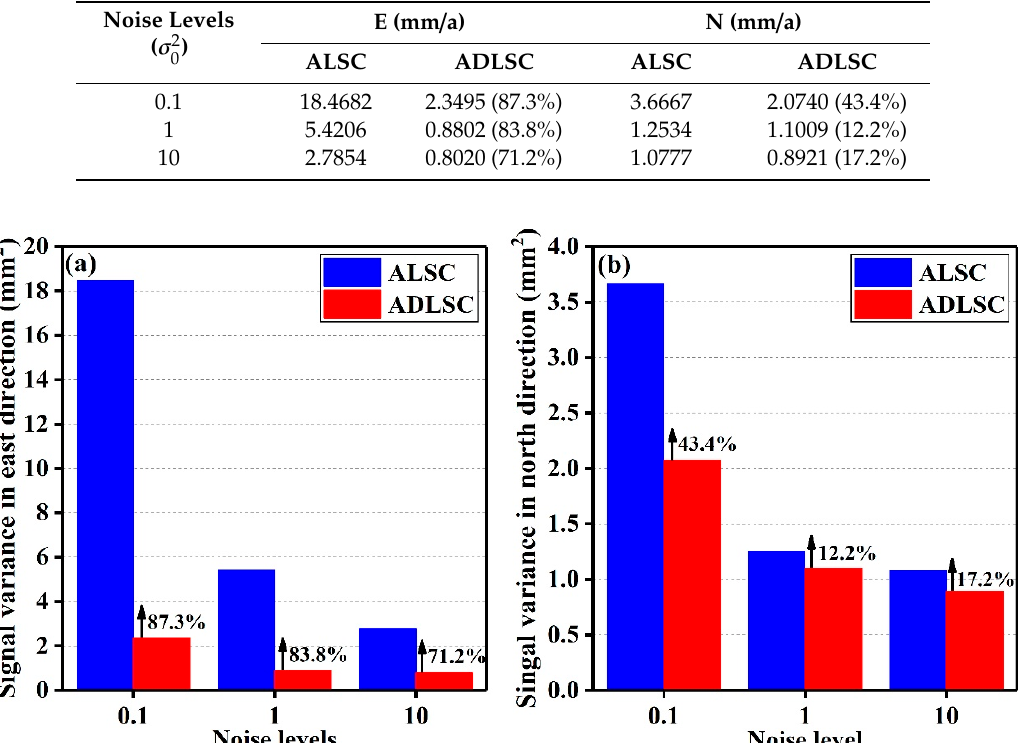
Figure 8. Comparison of the signal variance estimated results by the first Helmert VCEM calculation of the two algorithms under different noise levels: ( a ) east direction; ( b ) north direction.